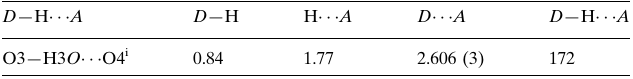
Hydrogen-bond geometry (A˚ , (cid:1)